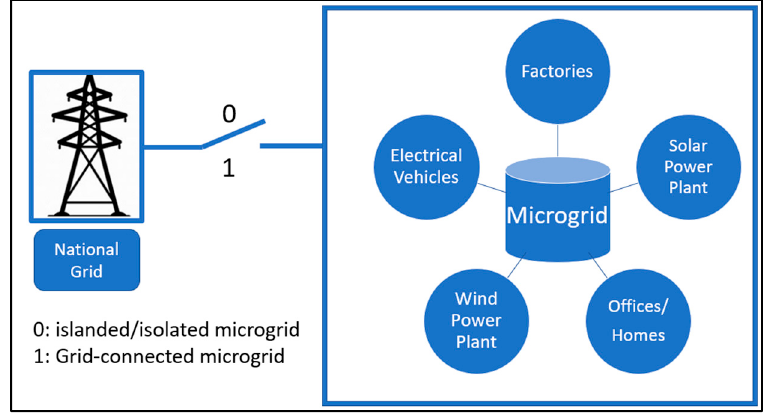
Figure 2. Microgrid